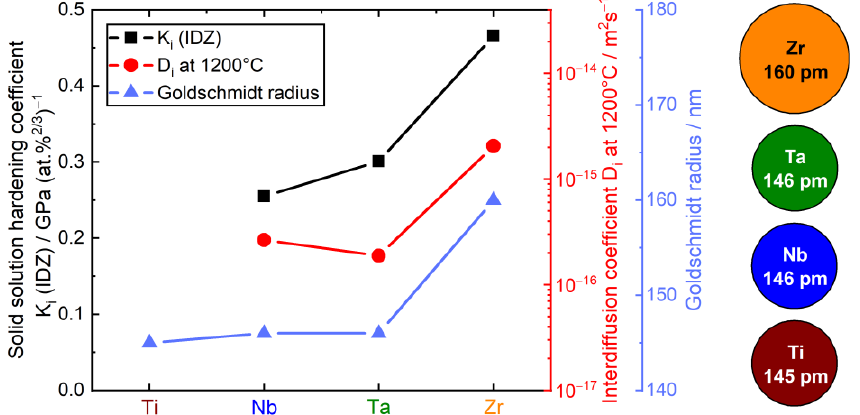
Figure 8. Solid solution hardening coefficients K i , interdiffusion coefficients D i determined on the interdiffusion zones and the Goldschmidt radii (reproduced from Ref. [36]) of the three investigated alloying elements Nb, Ta and Zr and Ti in γ -Ti-54Al.